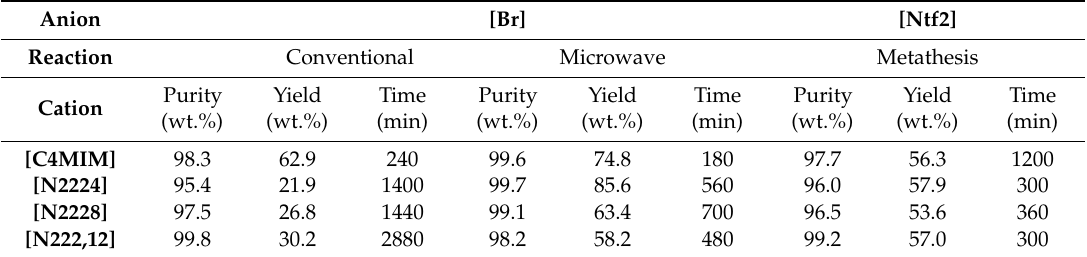
Table 1. Results of ionic liquid